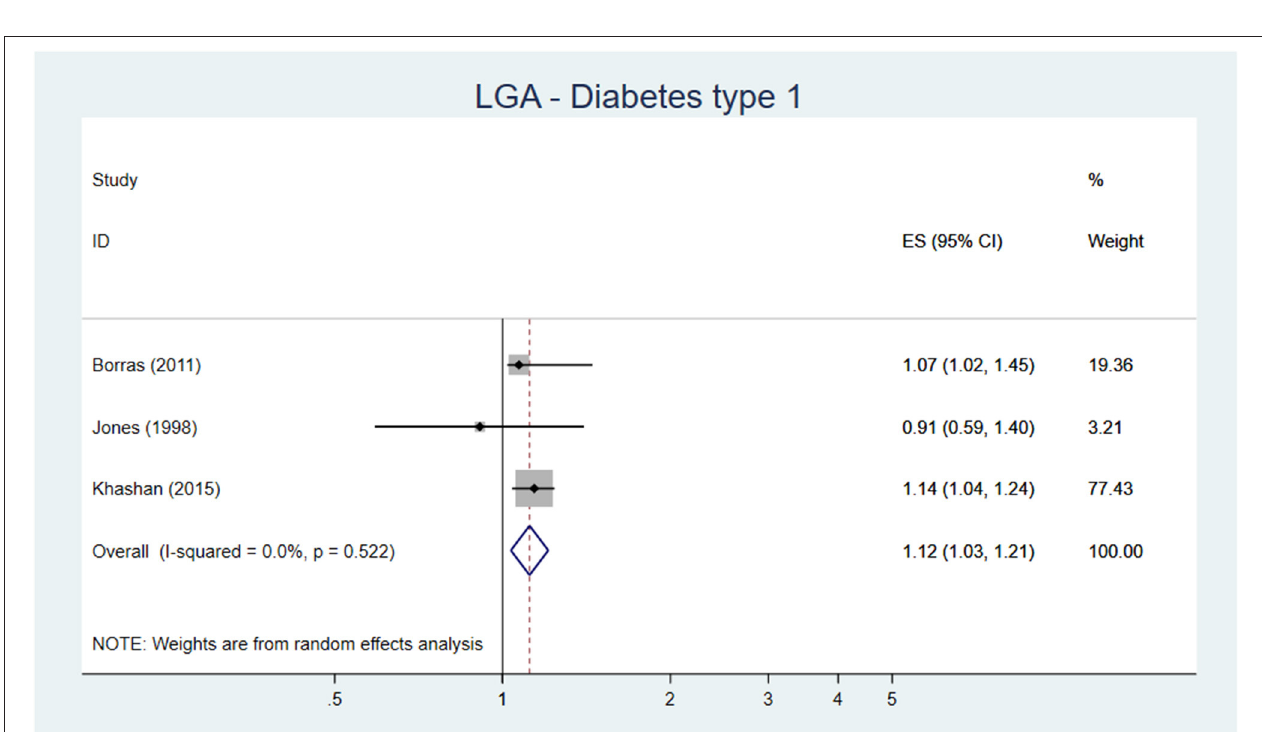
FIGURE 9 | Forest plot describing the association between high birth weight and Diabetes type 1.